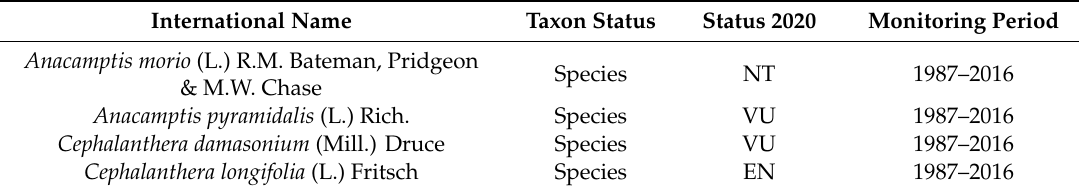
Table 1. The 51 orchids recorded in Denmark, their taxonomic status [5], Danish Red List status [4], and period of monitoring of 45 orchids in the National Orchid Monitoring Program. Red List categories: RE = regionally extinct; CR = critically endangered; EN = endangered; VU = vulnerable; NT = near threatened; LC = least concern; NE = not